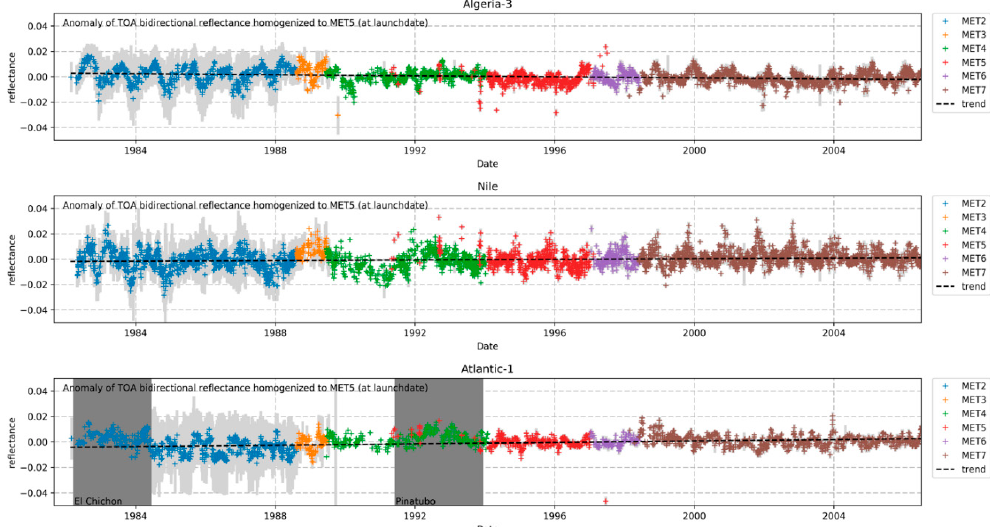
Figure 12. Anomalies of the homogenised reflectance time series and their trends. Anomalies are the deviation from the mean annual reflectance cycles. Additional filtering for cloud contamination was applied. The filter computes the 25th percentile from a rolling kernel of 30 days around each reflectance measurement. Measurements that are brighter than this value are rejected in order to display only measurements that are certainly cloud free. Note that for the Atlantic site the periods with globally elevated aerosol loads due to volcanic eruptions are excluded from the stability analysis.